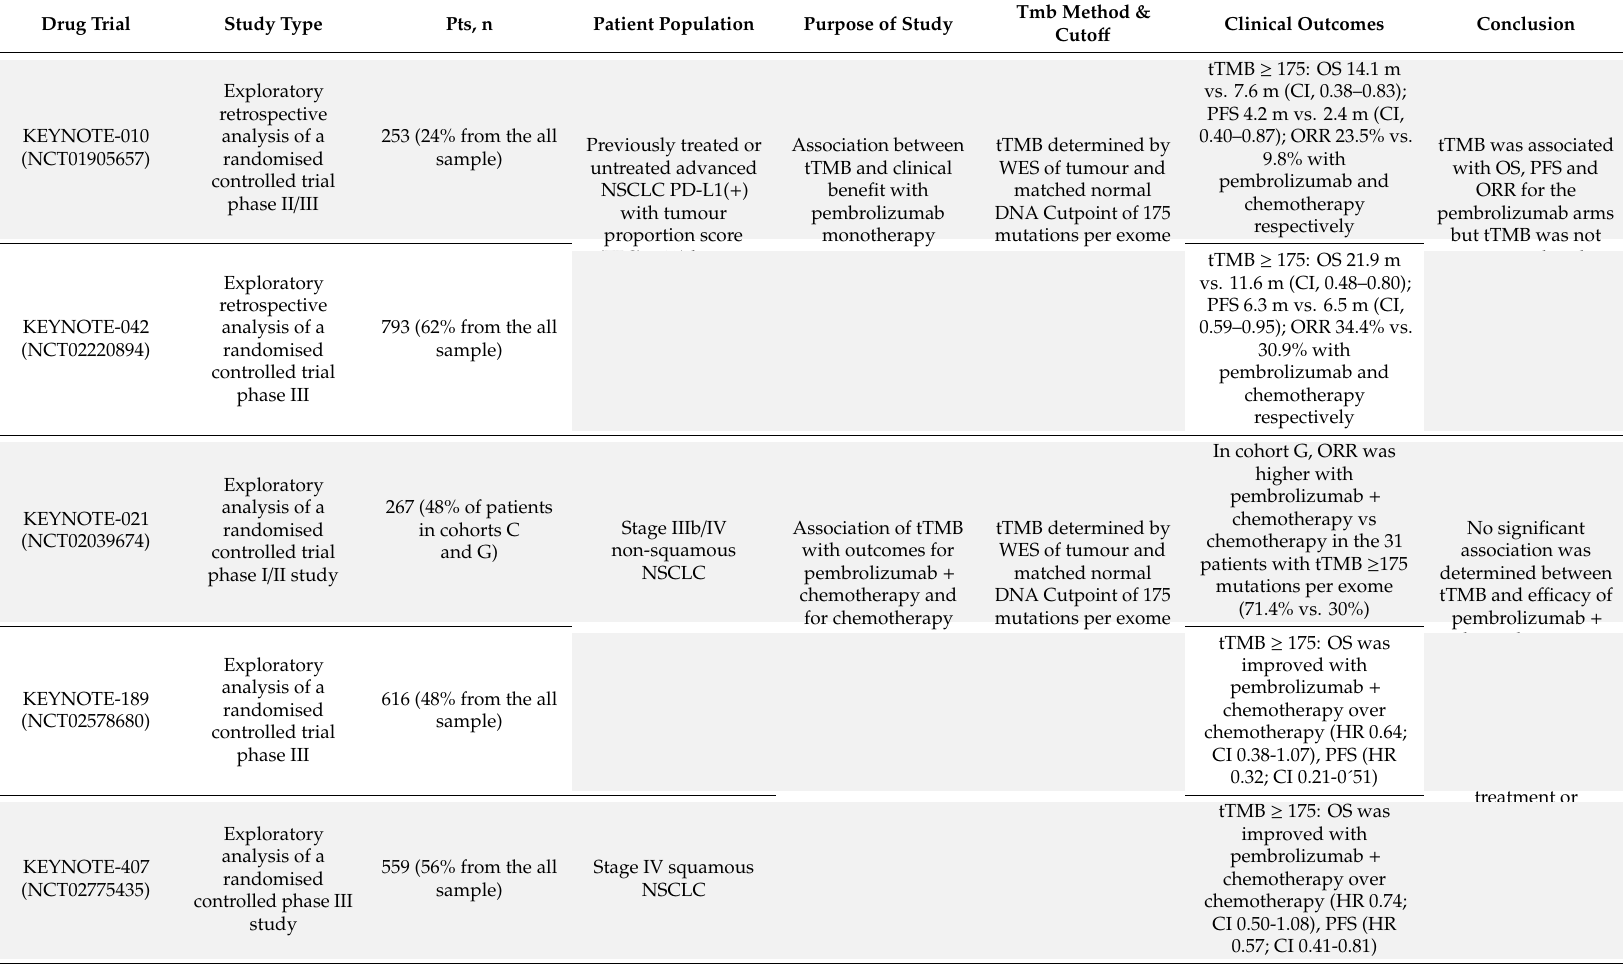
Table 2. Studies on TMB analysis as a negative biomarker of response to